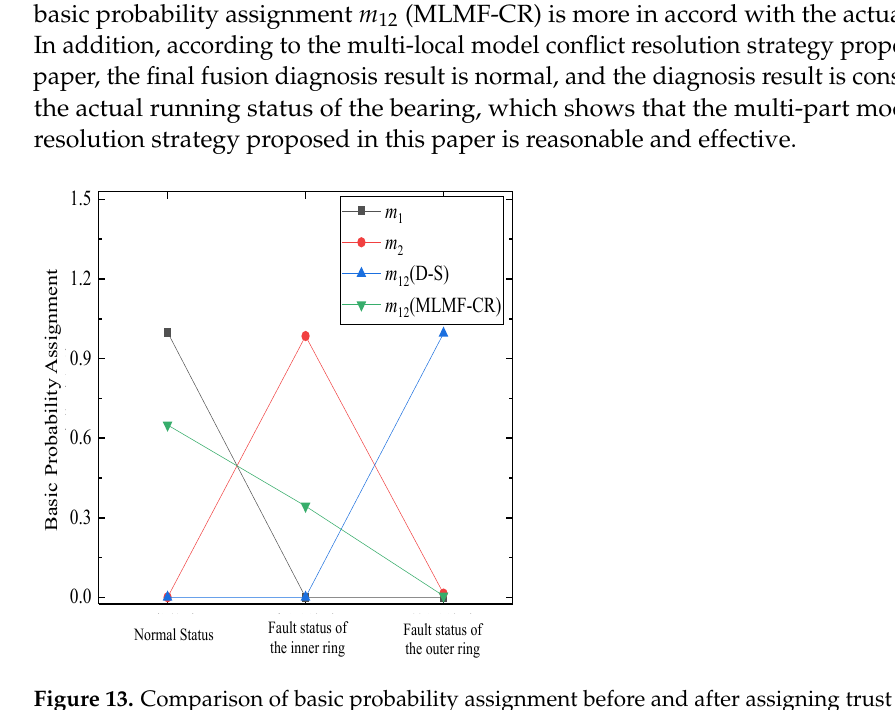
Figure 13. Comparison of basic probability assignment before and after assigning trust degree.